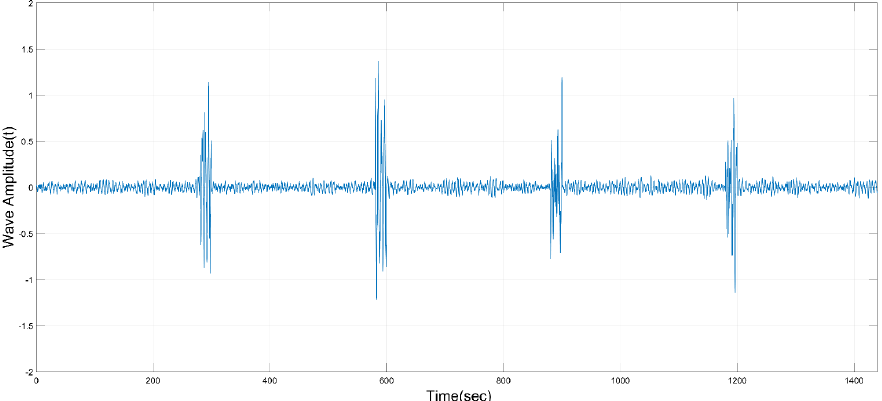
Figure 11. The variation of waves with time.